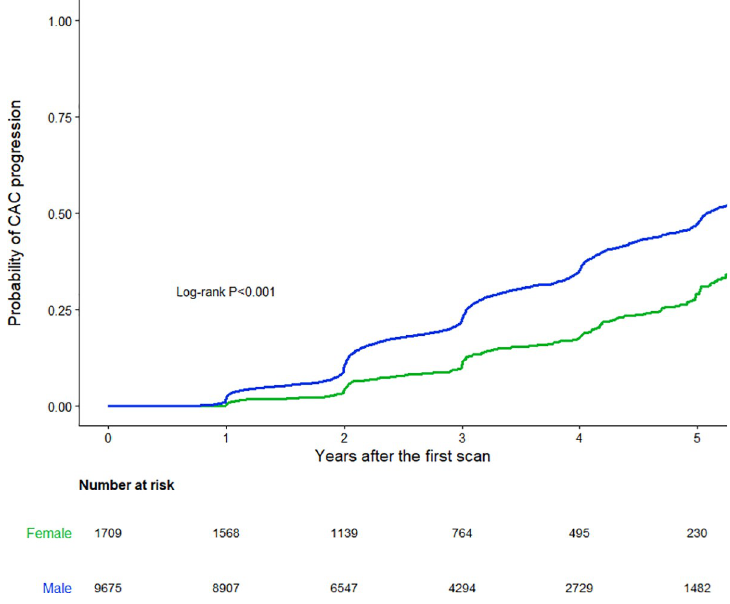
Fig 3. Kaplan-Meier 5-year CAC progression for men versus women in asymptomatic Korean individuals. CAC, coronary artery calcium.